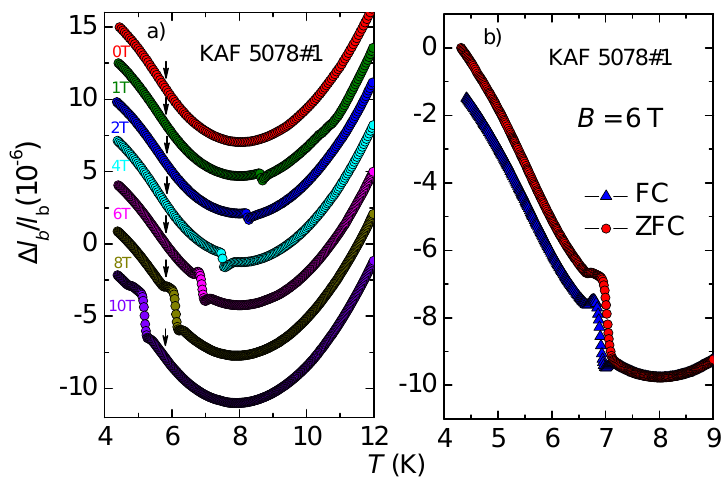
Figure 4. ( a ) Temperature-dependent relative length changes, ∆ l b / l b , for κ -(BEDT-TTF) 2 Cu 2 (CN) 3 (KAF 5078#1) along the b -axis for various constant magnetic fields between 0 T to 10 T. The curves were shifted along the y -axis for clarity. The arrows indicate the phase transition at 6 K for the various fields, giving rise to a peak in the thermal expansion coefficient, α b . ( b ) Relative length changes for zero-field cooling (ZFC) and field cooling (FC) at a constant field value of 6 T. Measurements were performed with a very slow rate of ± 1.5